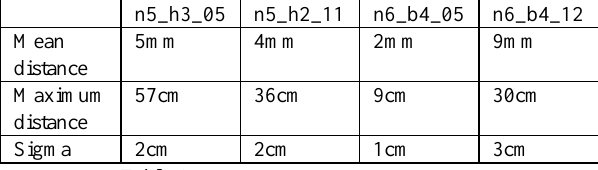
Figure 10: 3D point clouds